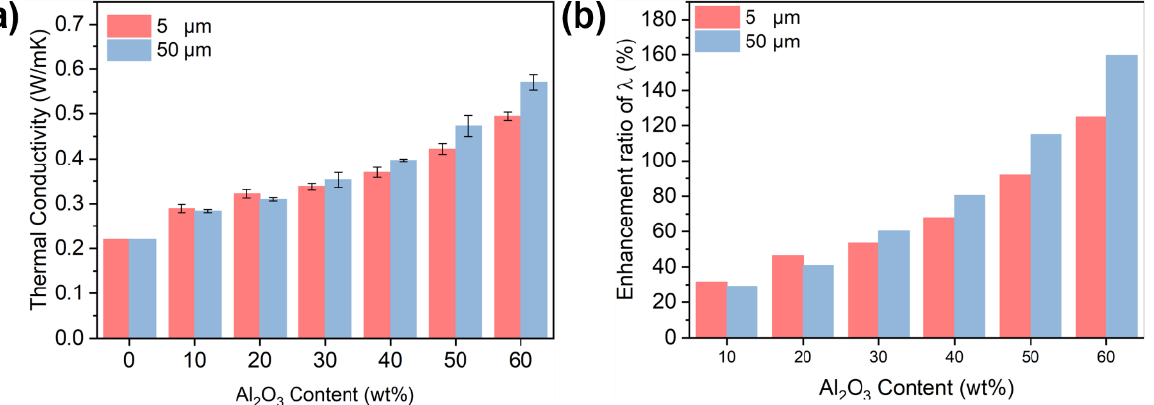
Figure 1. ( a ) Thermal conductivity ( λ ) and ( b ) enhancement ratio of λ of PC/Al 2 O 3 composites in comparison with pure PC: influence of particle size and filler concentration.